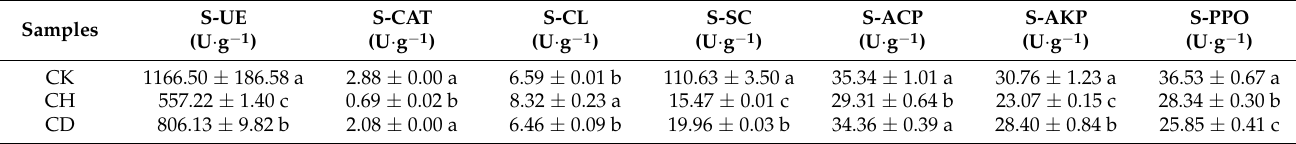
Table 4. Enzyme activities of three soil